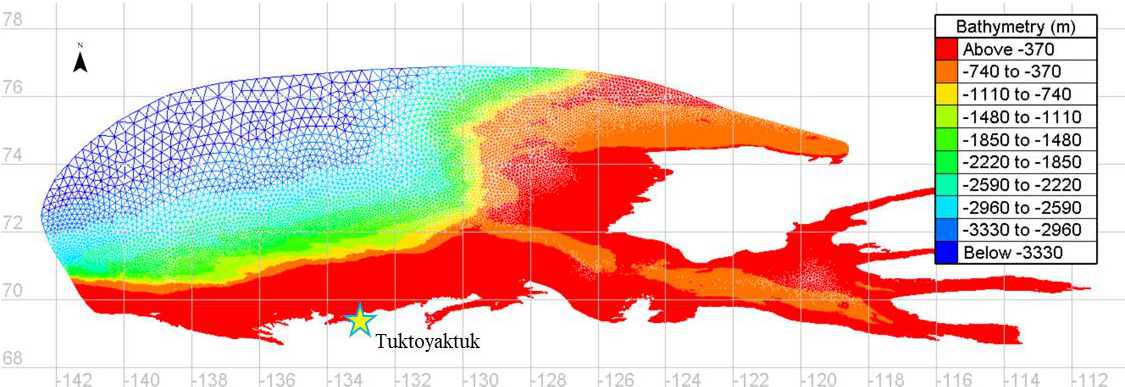
Figure 6. Numerical hydrodynamic model computational mesh and bathymetry.